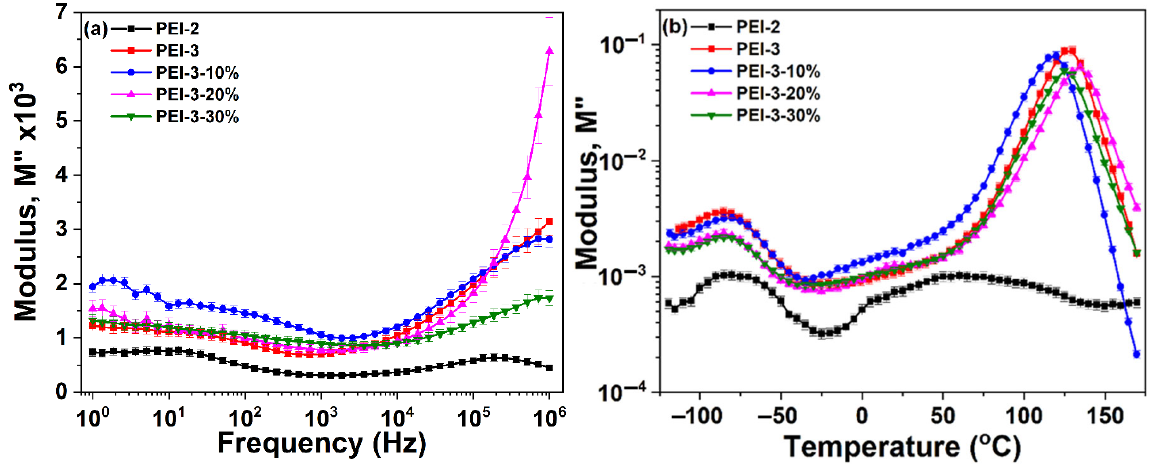
Figure 12. The evolution of modulus with frequency at room temperature ( a ) and with temperature at 10 Hz ( b ) for the studied materials.